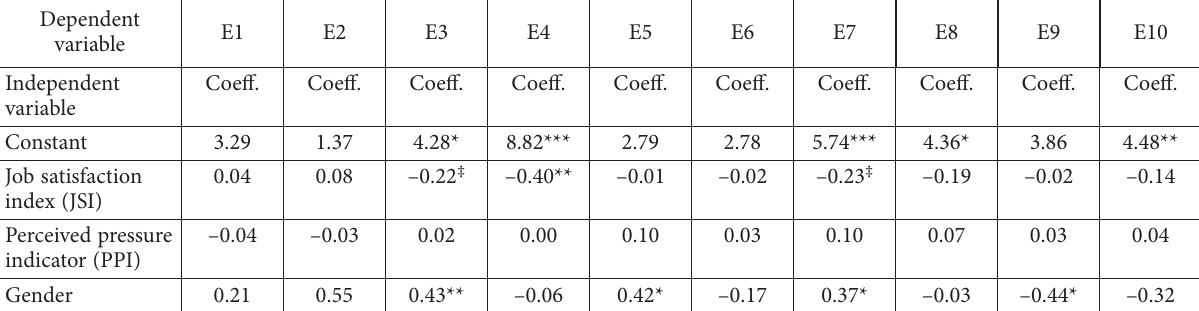
Table 5. Models estimates based on the 2SLS method for each ethical